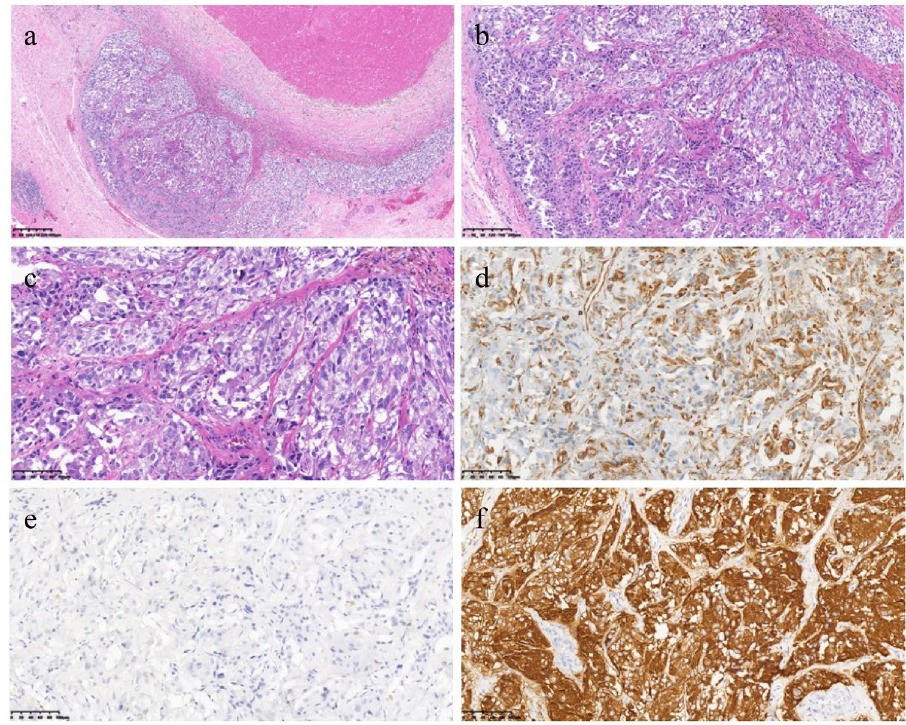
Figure 5: Histopathological fi ndings and immunohistochemical staining. ( a ) Hematoxylin – eosin ( HE ) staining (× 40 ) ; ( b ) He staining (× 100 ) ; ( c ) HE staining (× 200 ) ; ( d ) immunostaining for vimentin (× 100 ) ; ( e ) immunostaining for CK (× 100 ) ; ( f ) immunostaining for Syn (× 100 )